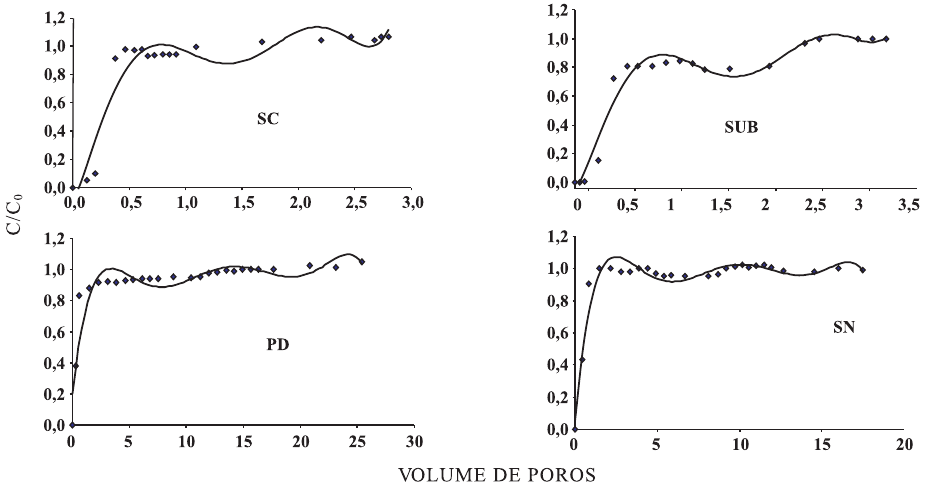
Valores representam médias (n = 4) ± DPM (desvio-padrão da